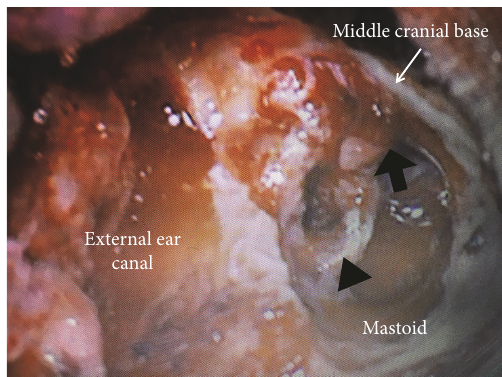
Figure 4: Intraoperative picture showing pulsating bleeding was seen from the dura in the middle cranial fossa (arrow) in removing the cholesterol granuloma (arrowhead) from the dura. Black arrow indicates the dura in the middle cranial fossa.